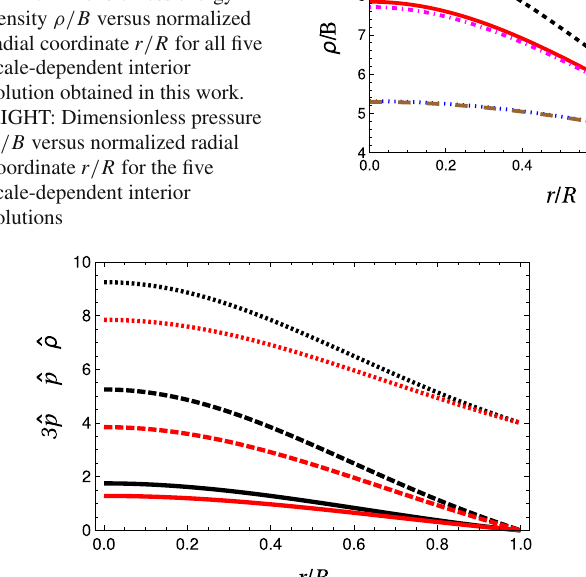
Fig. 3 Energy conditions: Normalized pressure p / B (solid, lower curves), normalized energy density ρ/ B (dotted, upper curves) and 3 p / B (dashed curves) versus dimensionless radial coordinate r / R for GR (curves in black) and for the solution p c = 1 . 288 B and ν = − 0 . 475 (curves in c